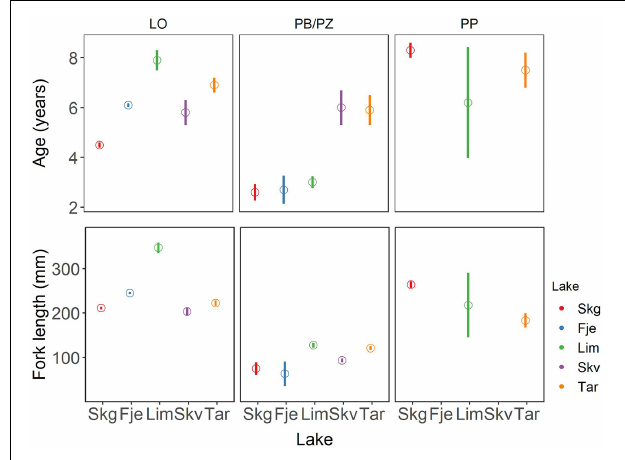
FIGURE 4 | Age and length where 50% of the population is mature in three Arctic charr morphs from the 5 studied lakes. Open circles represent the estimated obtained from logistic regression with standard error. Skg, Skogsfjordvatn; Fje, Fjellfrøsvatn; Lim, Limingen; Skv, Skøvatn; and Tar,